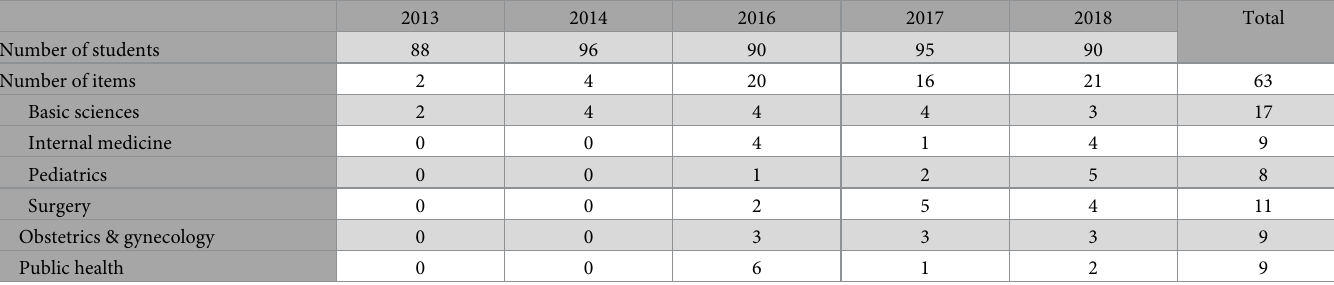
Table 1. Distribution of the number of students and number of items previously